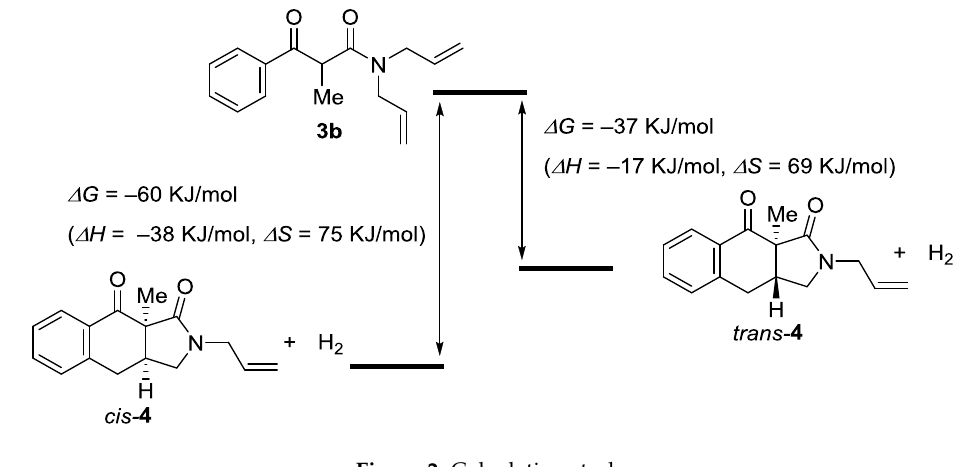
Figure 2. Calculation study.